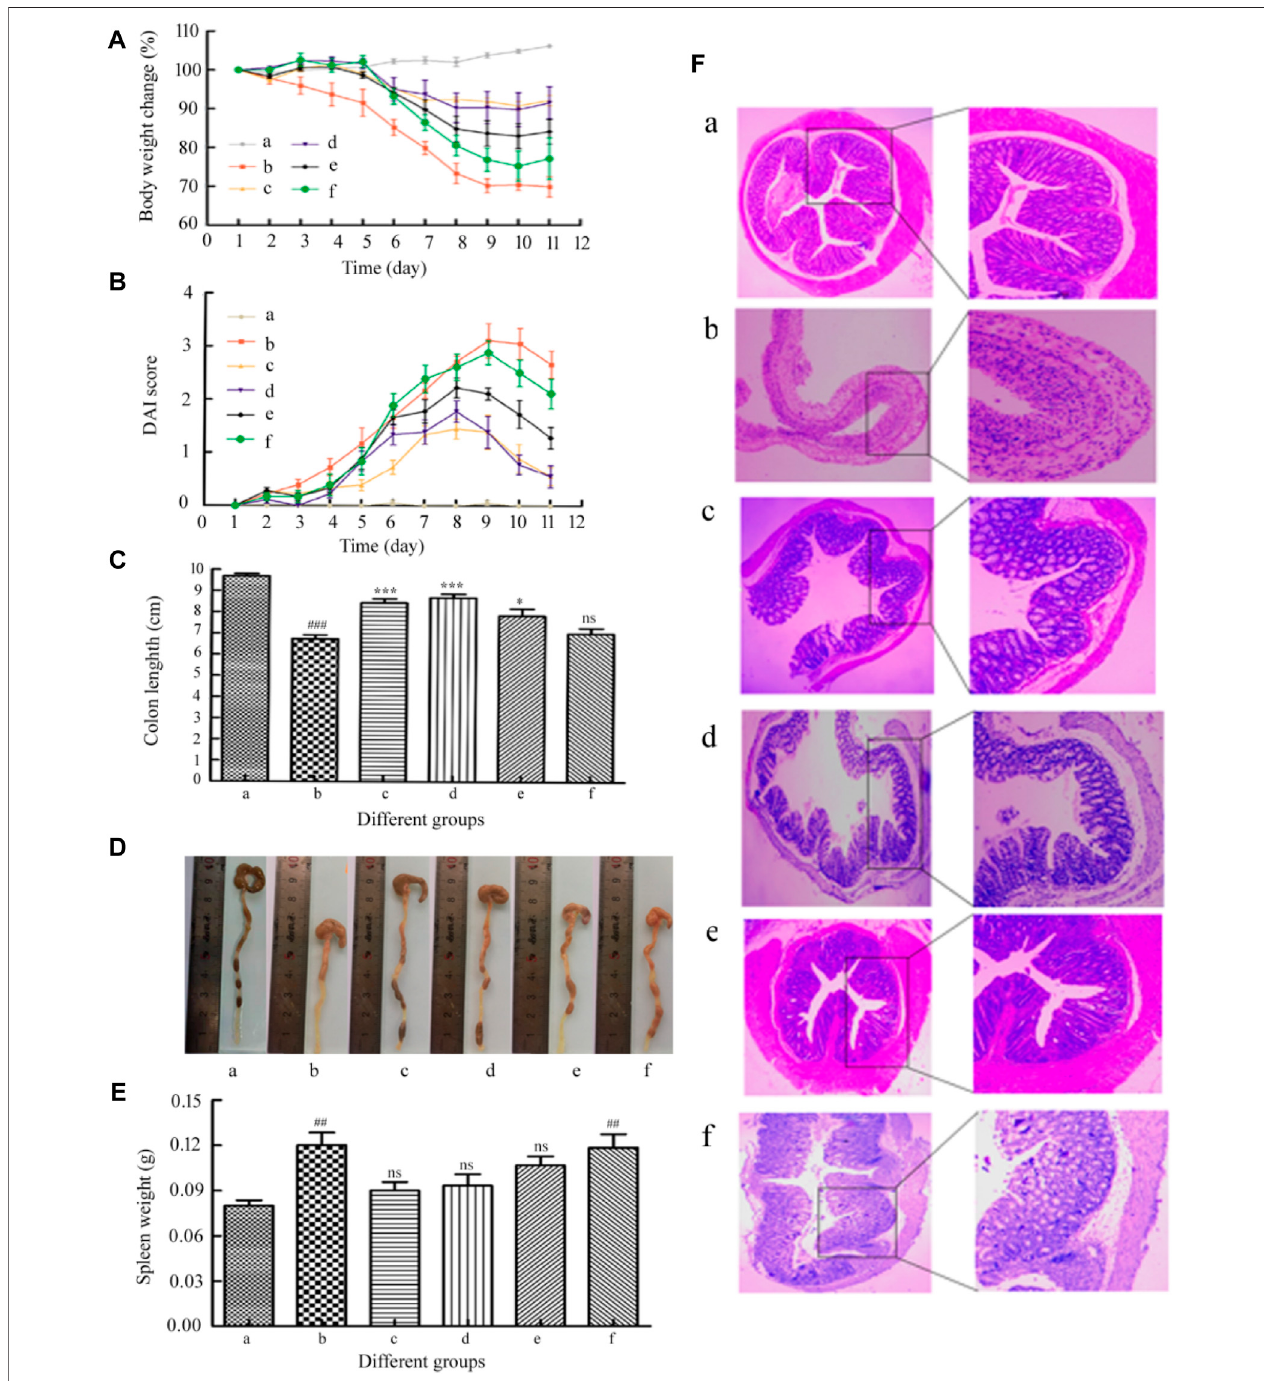
FIGURE7|(A) Lossofbasalbodyweightunderdifferenttreatmentsduringthediseaseprocess. (B) DAIunderdifferenttreatments. (C , D) Changesofcolonlength ineach groupofmice. (E) Spleenweight ofmiceineach group. (F) RepresentativeH&Estainingofthemousecolon.a,normal; b,DSS; c,thepositivedruggroup;d,the MSZ-loadedhydrogelgroup,e,theHP- β -CD/MSZinclusioncomplexgroup;andf,theblankhydrogelgroup. Dataarethemean ± SDofsixdata( n (cid:2) 6).Comparetothe DSS group, * p < 00.05, ** p < 0.01, *** p < 0.001; compared to normal group, # p < 0.05, ## p < 0.01, ### p < 0.001. (C) ns, no signi fi cance, compare to the DSS group; (E) ns, no signi fi cance, compare to normal group.